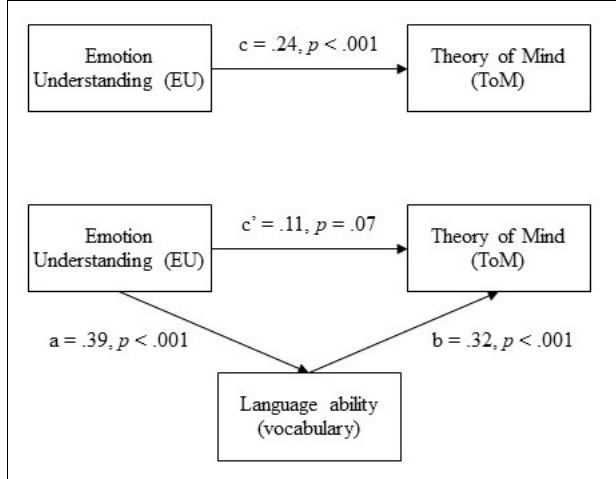
FIGURE 1 | The model of mediation with total (c) and direct effect (c (cid:48) ) of EU on ToM. Standardized effects were